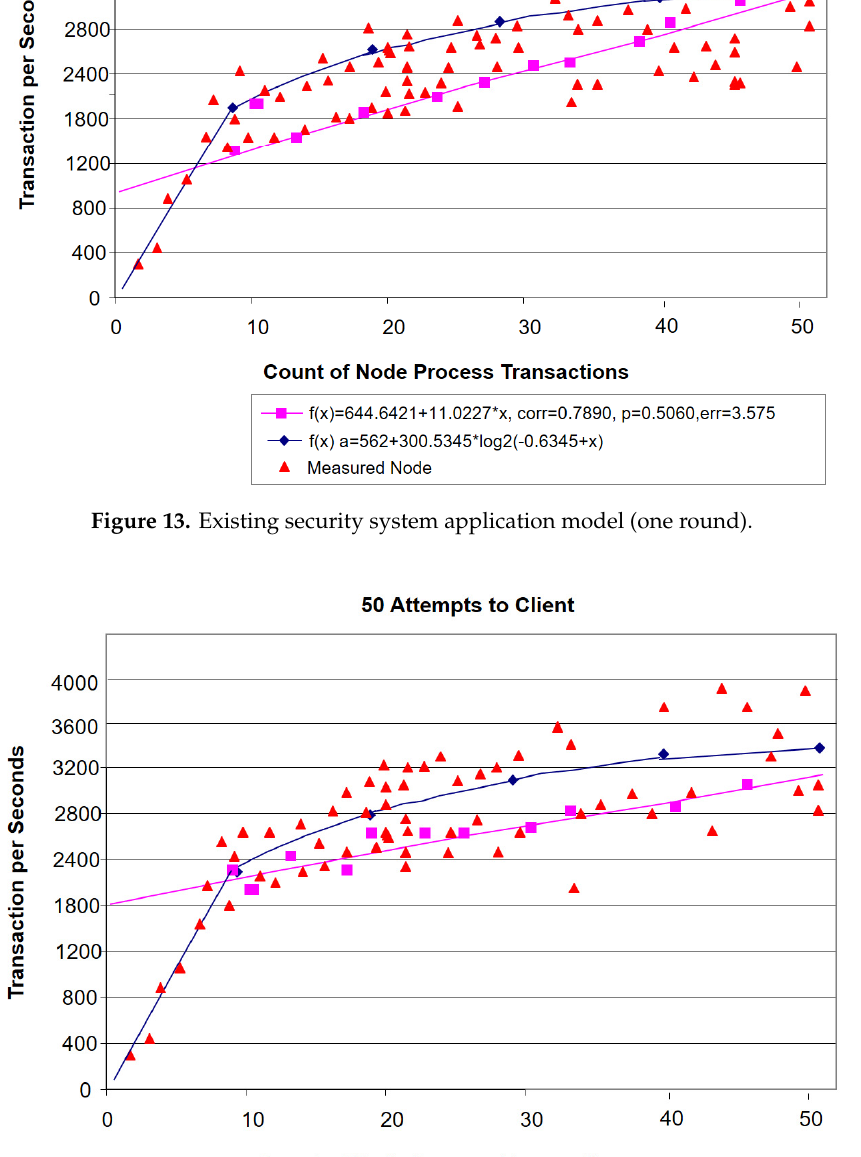
Figure 14. Existing security system application model (50 rounds).